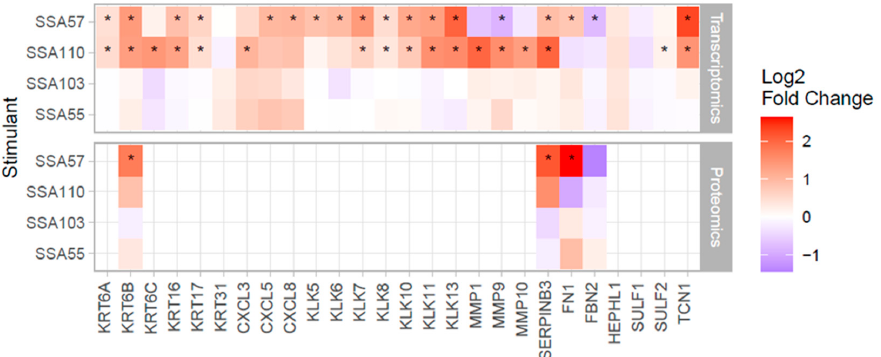
Figure 2. S. aureus secretomes increased expression of SCC biomarkers in human keratinocytes. Heatmaps show the gene (top) and protein (bottom) expression changes of biomarkers linked with SCC progression [30–35] in keratinocytes challenged with S. aureus secretome compared to control. * p < 0.05. Note, most of the biomarkers are highly secreted proteins, hence, they were not detected by shotgun proteomics of the cellular fraction.